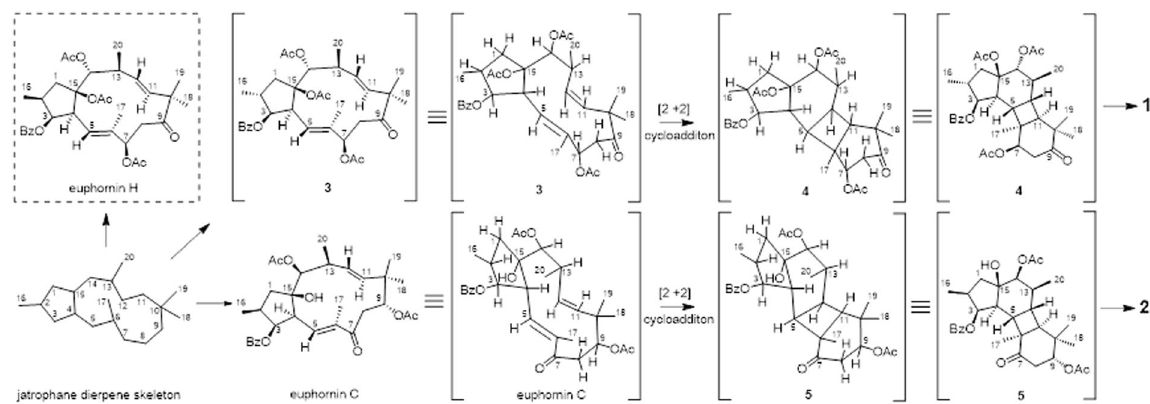
Figure 5. Plausible Biosynthetic Pathways of Heliosterpenoids A and B (1 and